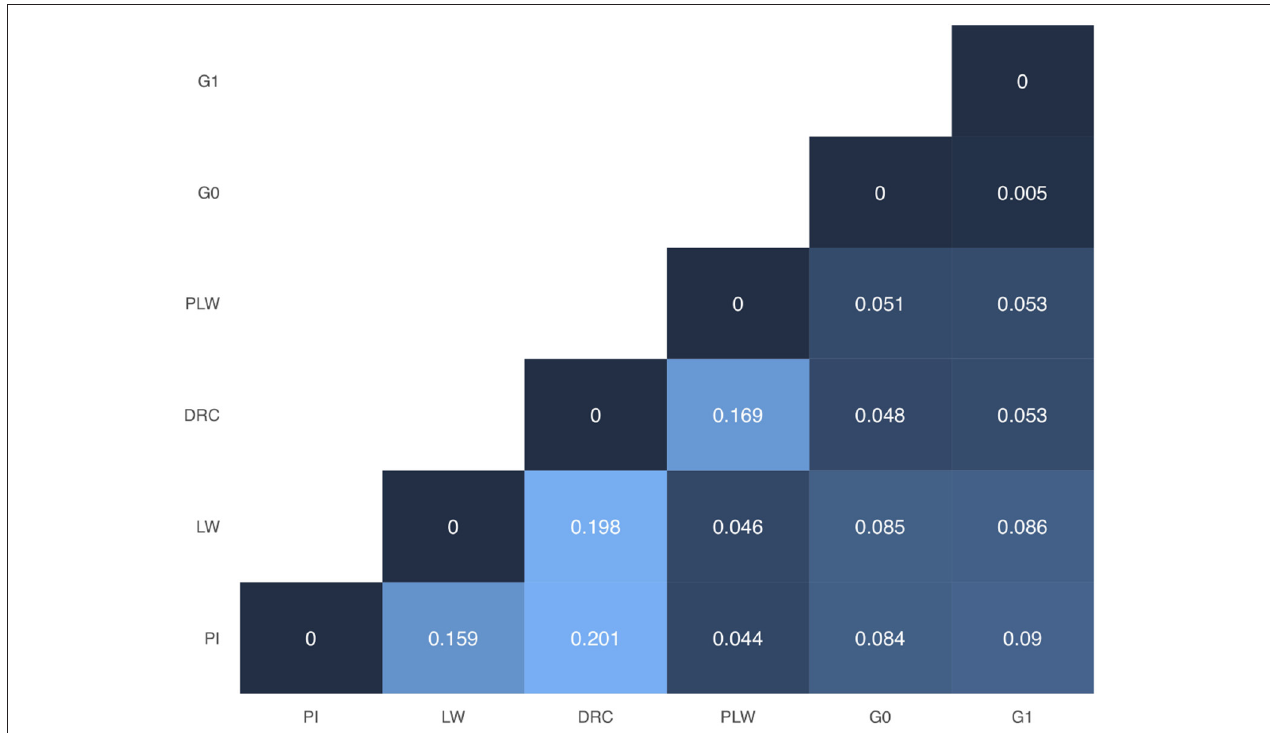
FIGURE 3 | Weir and Cockerham F ST heatmap for all groups. DRC, Duroc; G0, (Pietrain × Large White) × Duroc offspring; G1, G0 × G0 offspring; LW, Large White; PI, Pietrain; PLW, Pietrain × Large White.